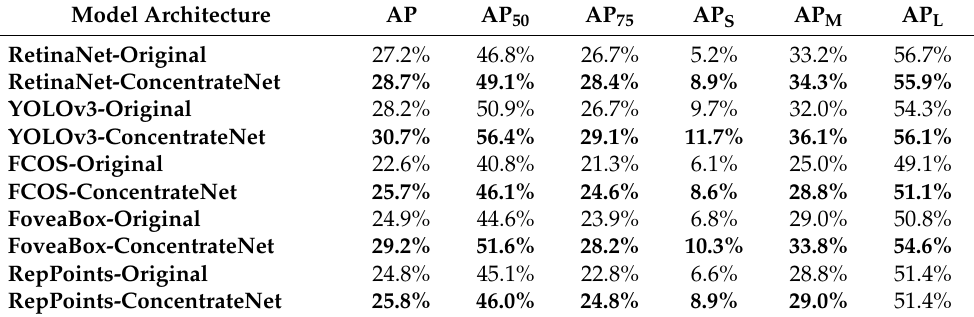
Table 6. Object detection precision evaluation results.